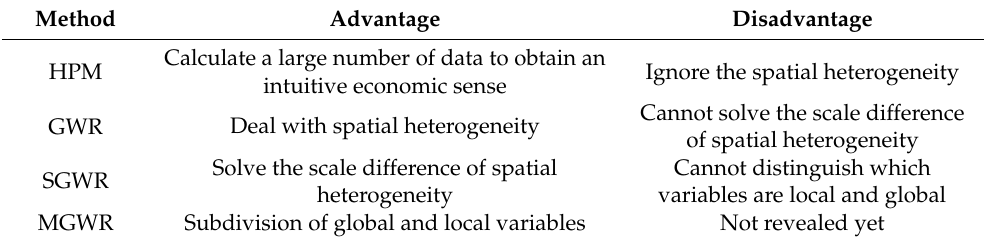
Table 2. Methods for identifying factors that influence private housing rental